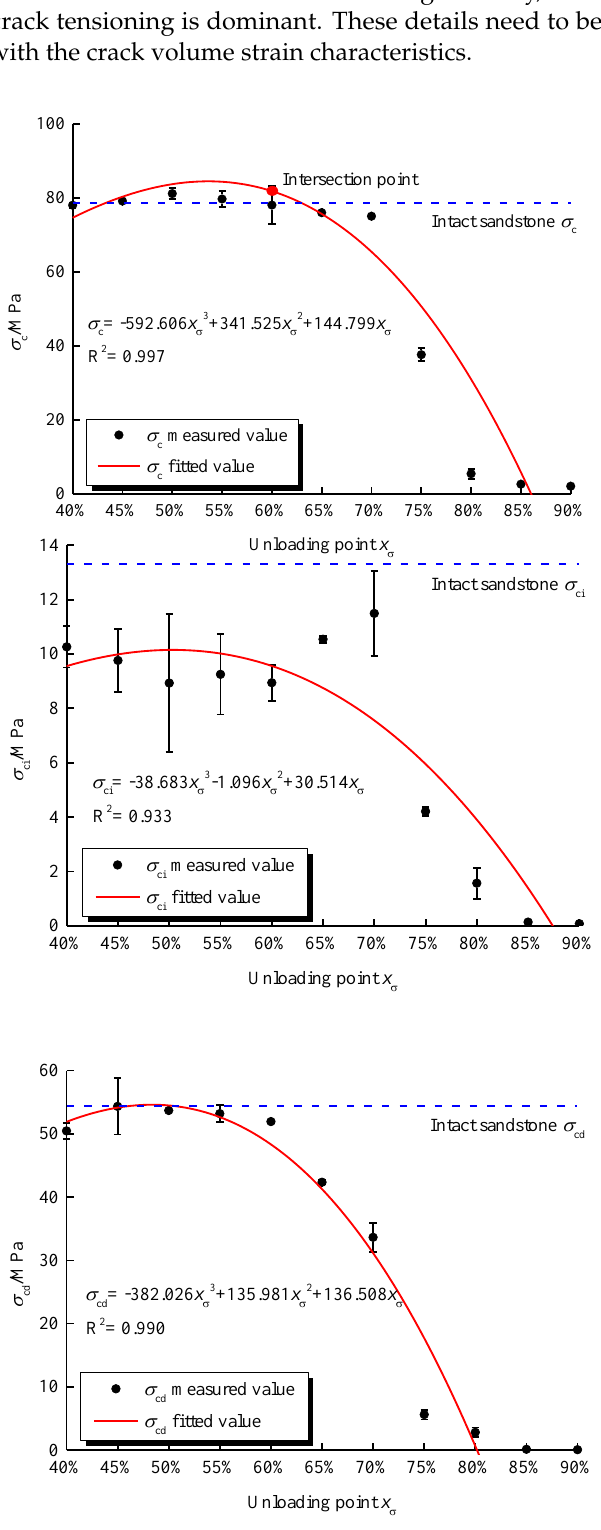
Figure 4. Relationship curve between characteristic stress and unloading point.